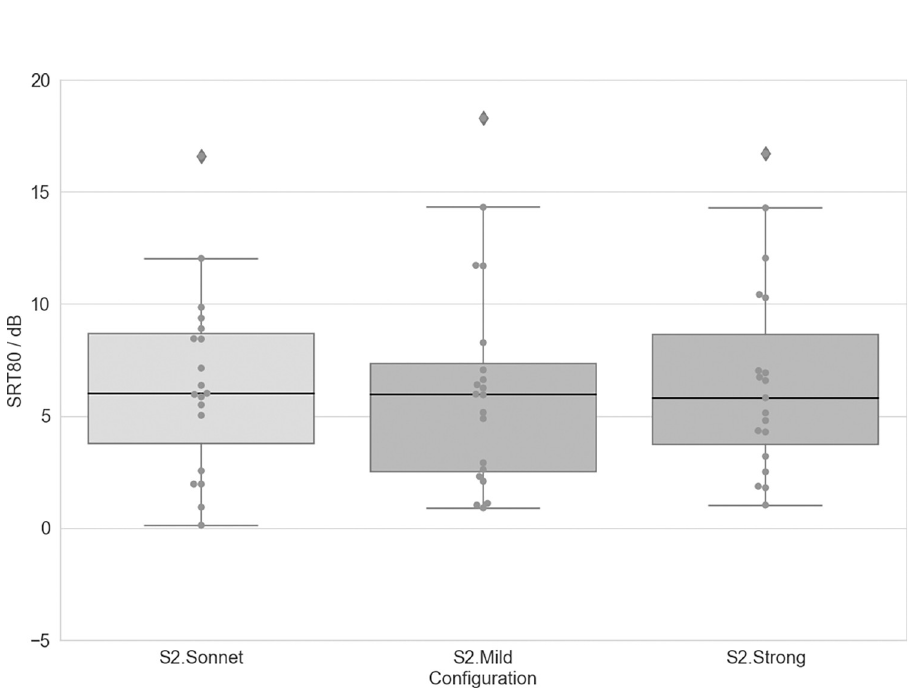
Fig 4. SRT80 observed in the OLSA S0N0T0 for each test configuration. Boxplots show median values as well as first and third quartiles. Whisker bars show minimum and maximum values within 1.5 interquartile ranges below and above the first and third quartile. Diamonds show